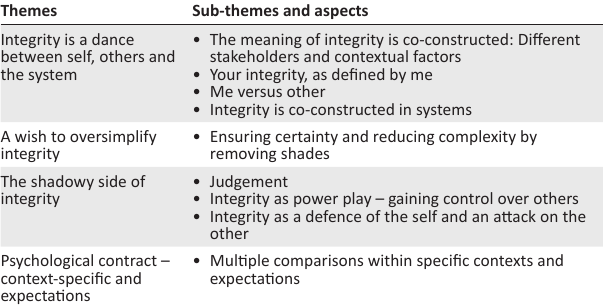
TABLE 1: Grouping of themes into sub-themes and related